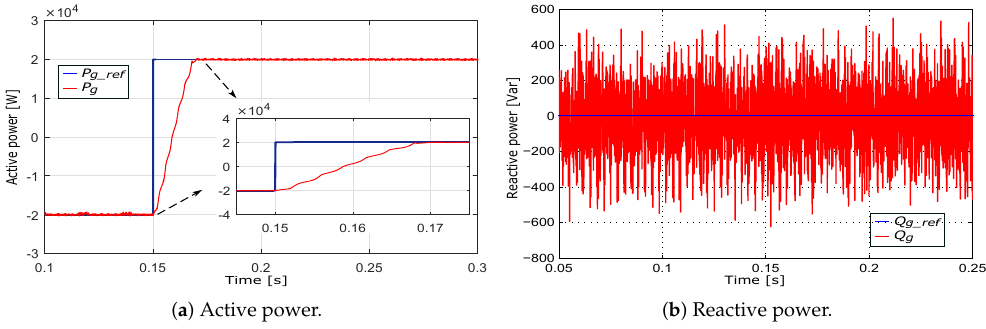
Figure 6. The transient power responses for a step in active power reference with a unity power factor.